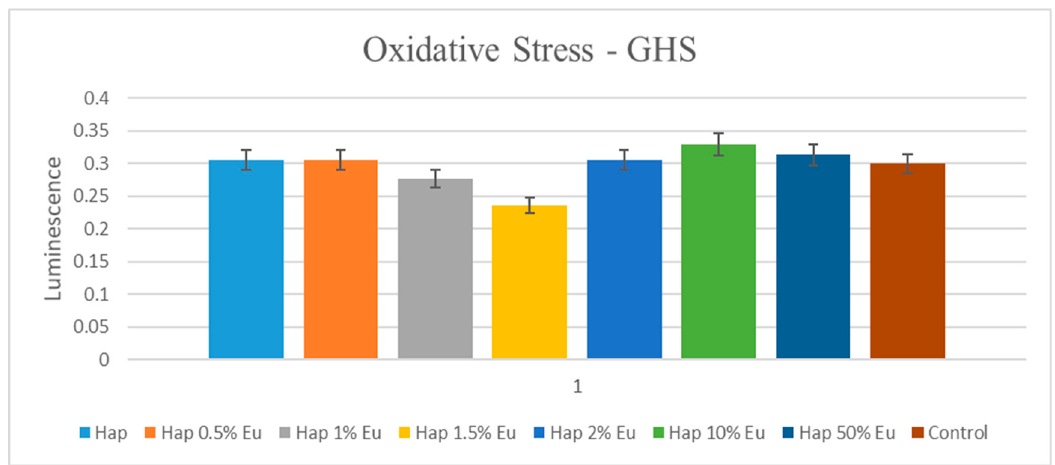
Figure 10. GSH assay showing the oxidative stress of AFSC in the presence of the Eu X HAp ceramic materials: HAp, Eu05HAp, Eu1HAp, Eu1.5HAp, Eu2HAp, Eu10HAp, Eu50HAp and control (cell only).